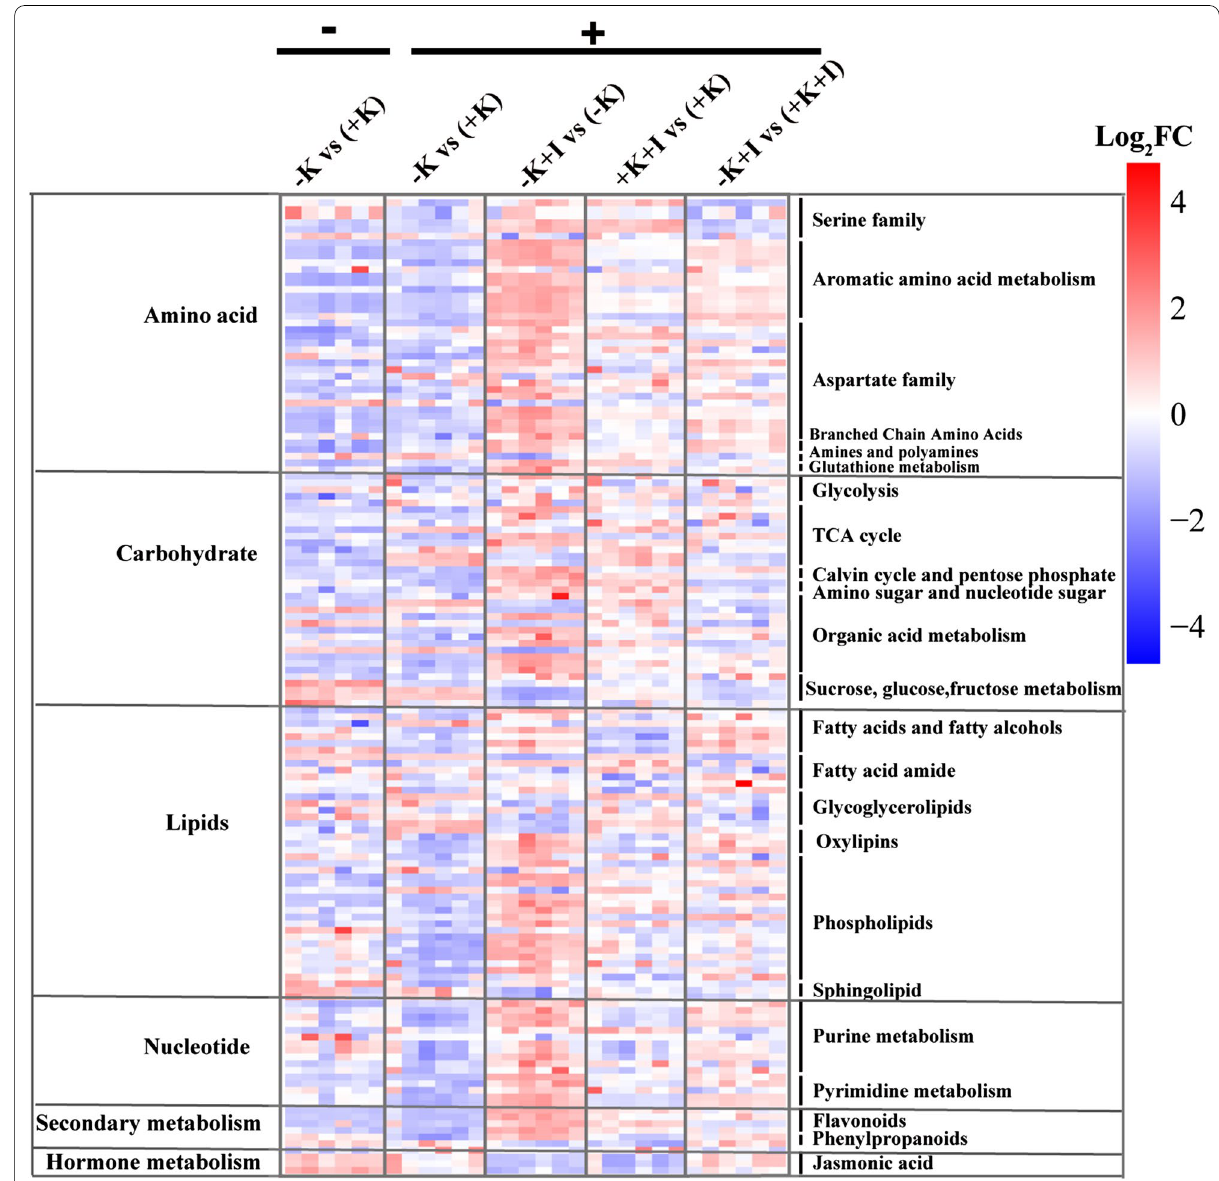
Fig. 2 Infection with S. oryzae substantially altered metabolomes under K-starvation and K sufficient conditions, especially with respect to amino acids and lipid products. The data shown are log 2 (Fold Change) values of the metabolites (n treatments in brackets were performed as controls. The 147 metabolites were clustered according to their metabolic pathways and functions, as suggested by previous study (McLoughlin et al. 2018). Additionally, p -value comparisons. Red denotes higher log 2 (FC) values for the treatments, and blue denotes higher log 2 (FC) values for the controls (indicated in brackets). and indicate before inoculation and 5 days after inoculation (sterile water or S. oryzae ), − +